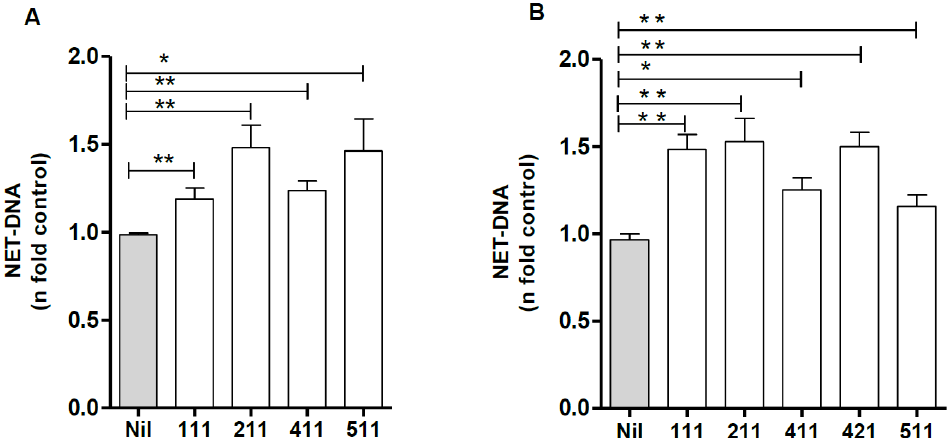
Figure 4. Laminin in solution or adsorbed onto plates induces NET release. Neutrophils were incubated with the indicated LM isoforms in suspension ( A ) or on coated plates ( B ) for 90 min, and NETs were quantified in culture supernatants using PicoGreen. The data were normalized according to spontaneous (Nil) release of DNA and are presented as the mean ± SEM of 7 ( A ) and 3 donors ( B ) for each isoform. * p < 0.05; ** p < 0.004.